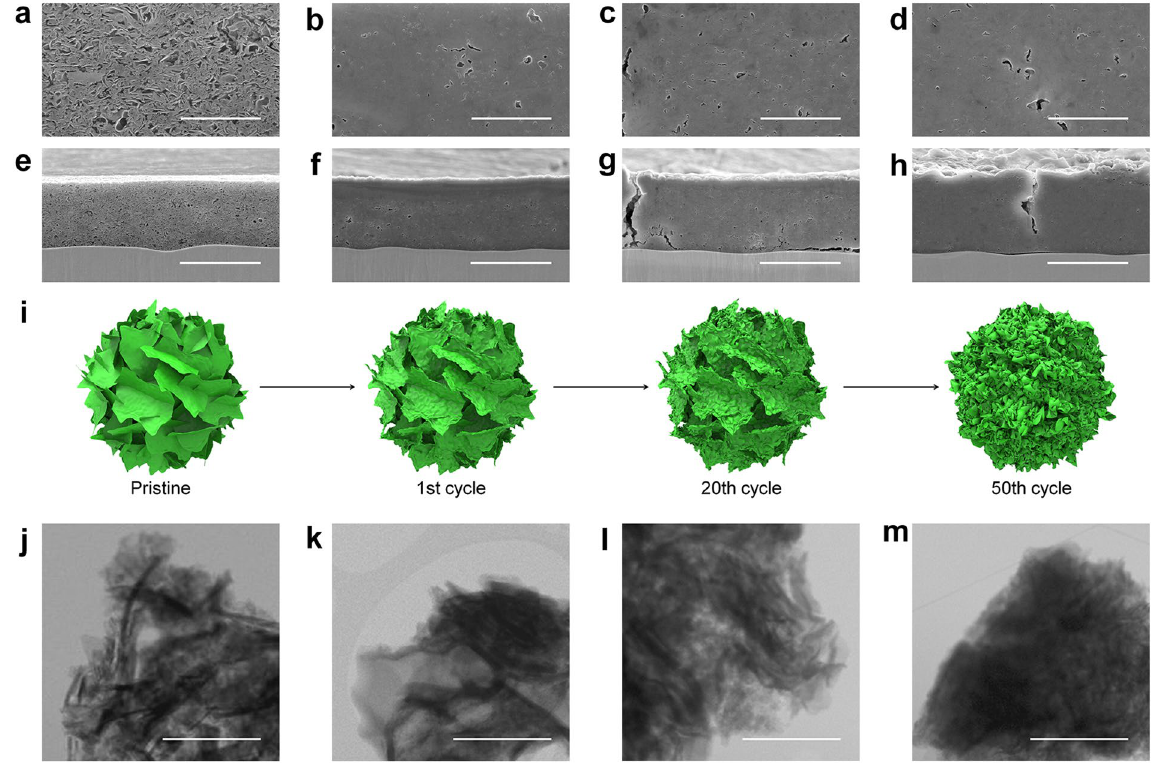
Figure 5. Comparison of structural stability of 2D Si/SiO x nanofoils (1000 °C) collected at different cycles. Top view FESEM images ( a – d ), cross-sectional FESEM images ( e – h ), and TEM images (j-m) of 2D Si/SiO x (1000 °C) electrode: pristine ( a , e , j ), after 1 cycle ( b , f , k ), after 20 cycles ( c , g , l ), and after 50 cycles ( d , h , m ), and ( i ) schematic illustrations of 2D